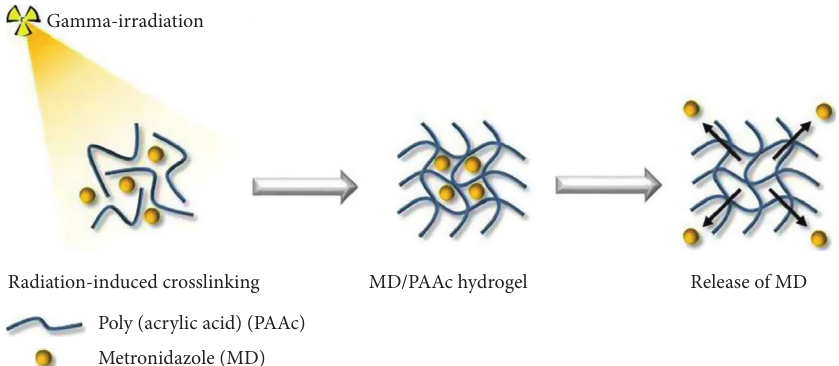
Figure 4: Schematic representation of the mechanism of the synthesis of hydrogels by the gamma-irradiation